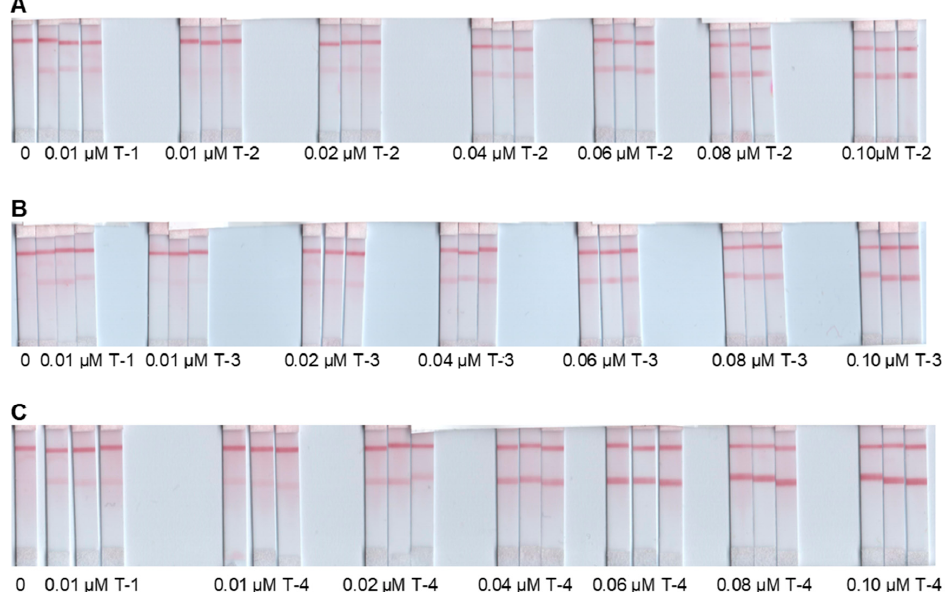
Figure 5. Results of selectivity tests against dengue serotypes 2, 3, and 4. Sets of LFB responses for blank (0), triplicates of 0.01 µM T-1, and triplicates of the different concentrations of ( A ) T-2, ( B ) T-3, and ( C ) T-4 as labeled.